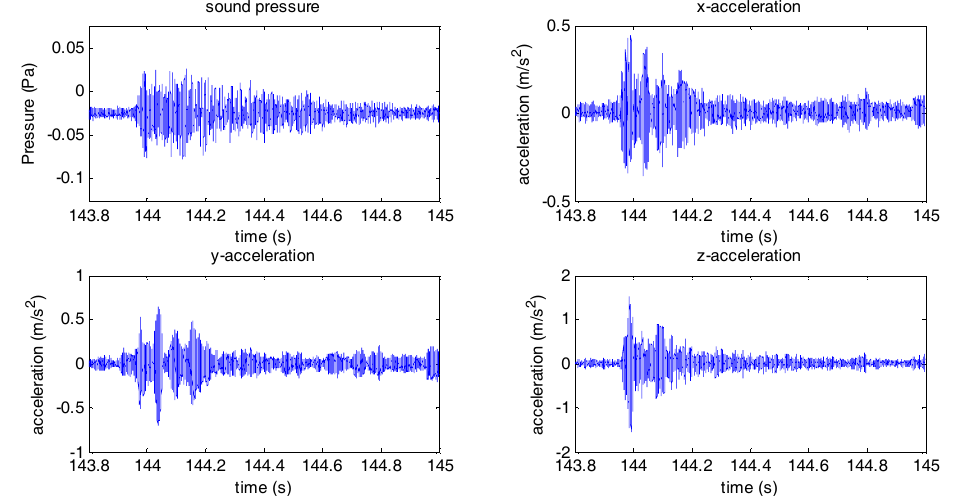
Figure 35. The sound pressure and vibrational signal received by the OBS.